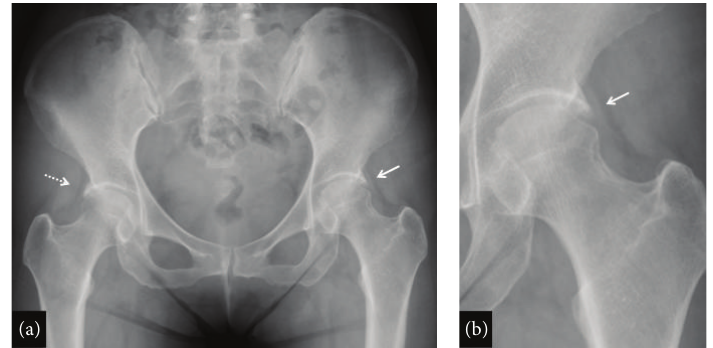
Figure 3: Plain radiographs at the last follow-up. (a) Anteroposterior X-ray obtained at the 2-year follow-up and (b) its enlarged image. Progressionof the subchondral collapse was not observed but theacetabular overcoverage in both hipsstill remained (a dotted arrowindicates right and a white arrow indicates left side of the acetabular